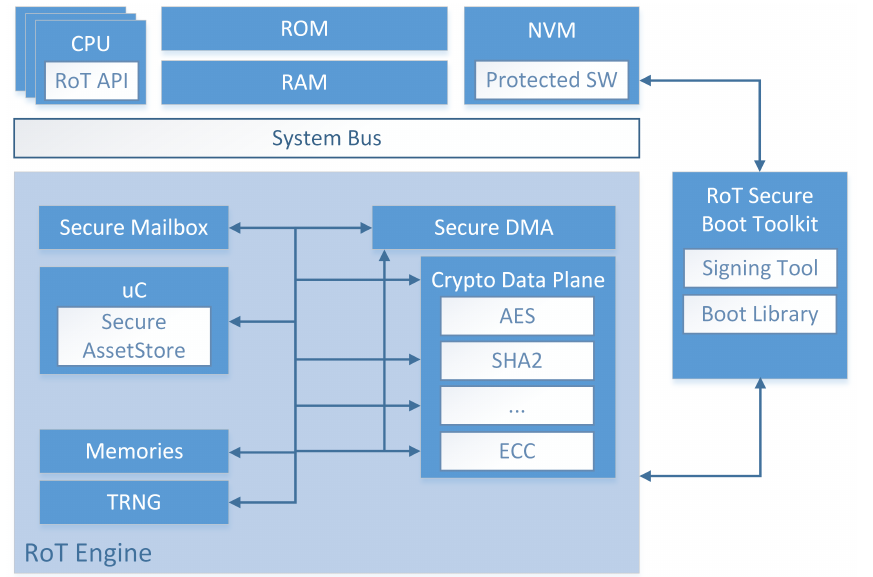
Figure 7. Rambus RT hardware architecture, on RT-100 example, based on [68]. Corresponding software elements (e.g., RoT Secure Boot Toolkit), and the location of this component in a system on chip are